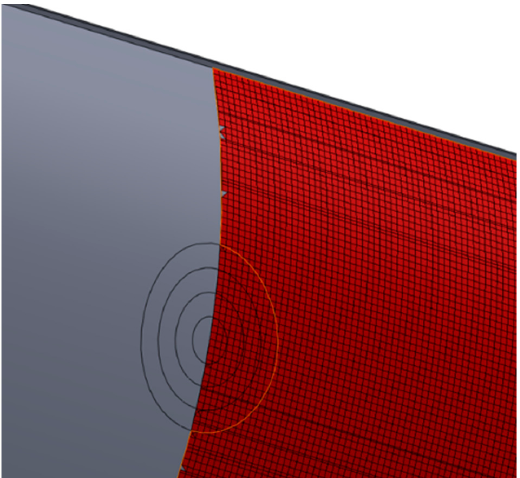
Figure 13. Volume elements at the shield surface on the symmetry domain.